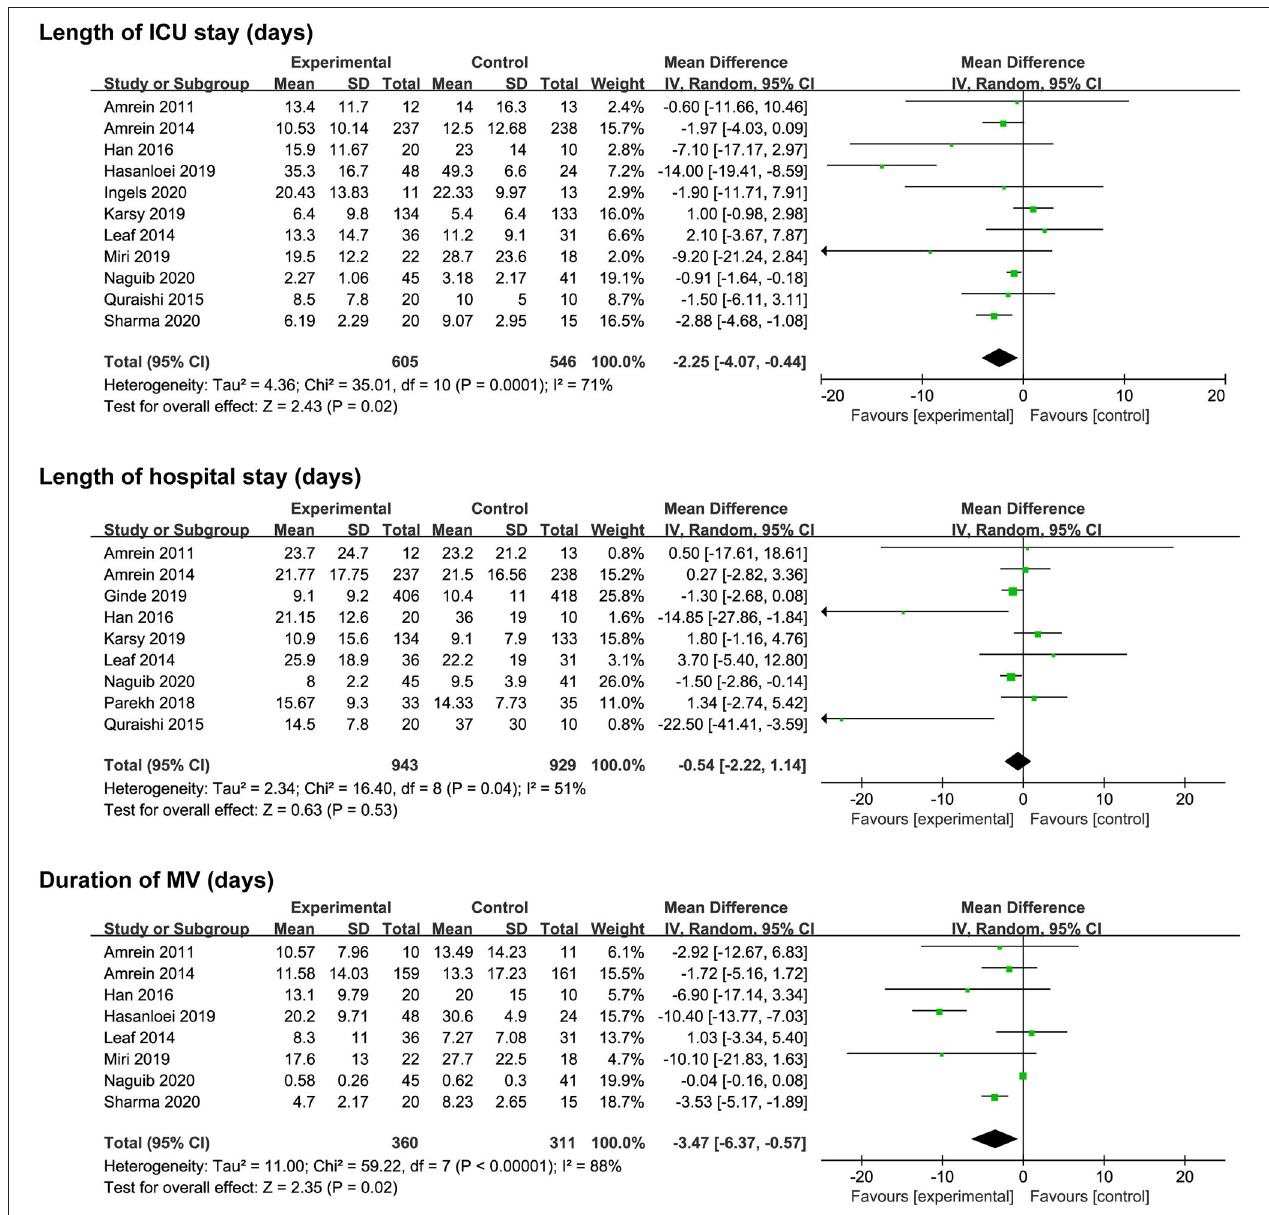
FIGURE 3 | Effect of vitamin D administration on length of ICU stay, length of hospital stays, and duration of MV. ICU, intensive care unit; MV, mechanical